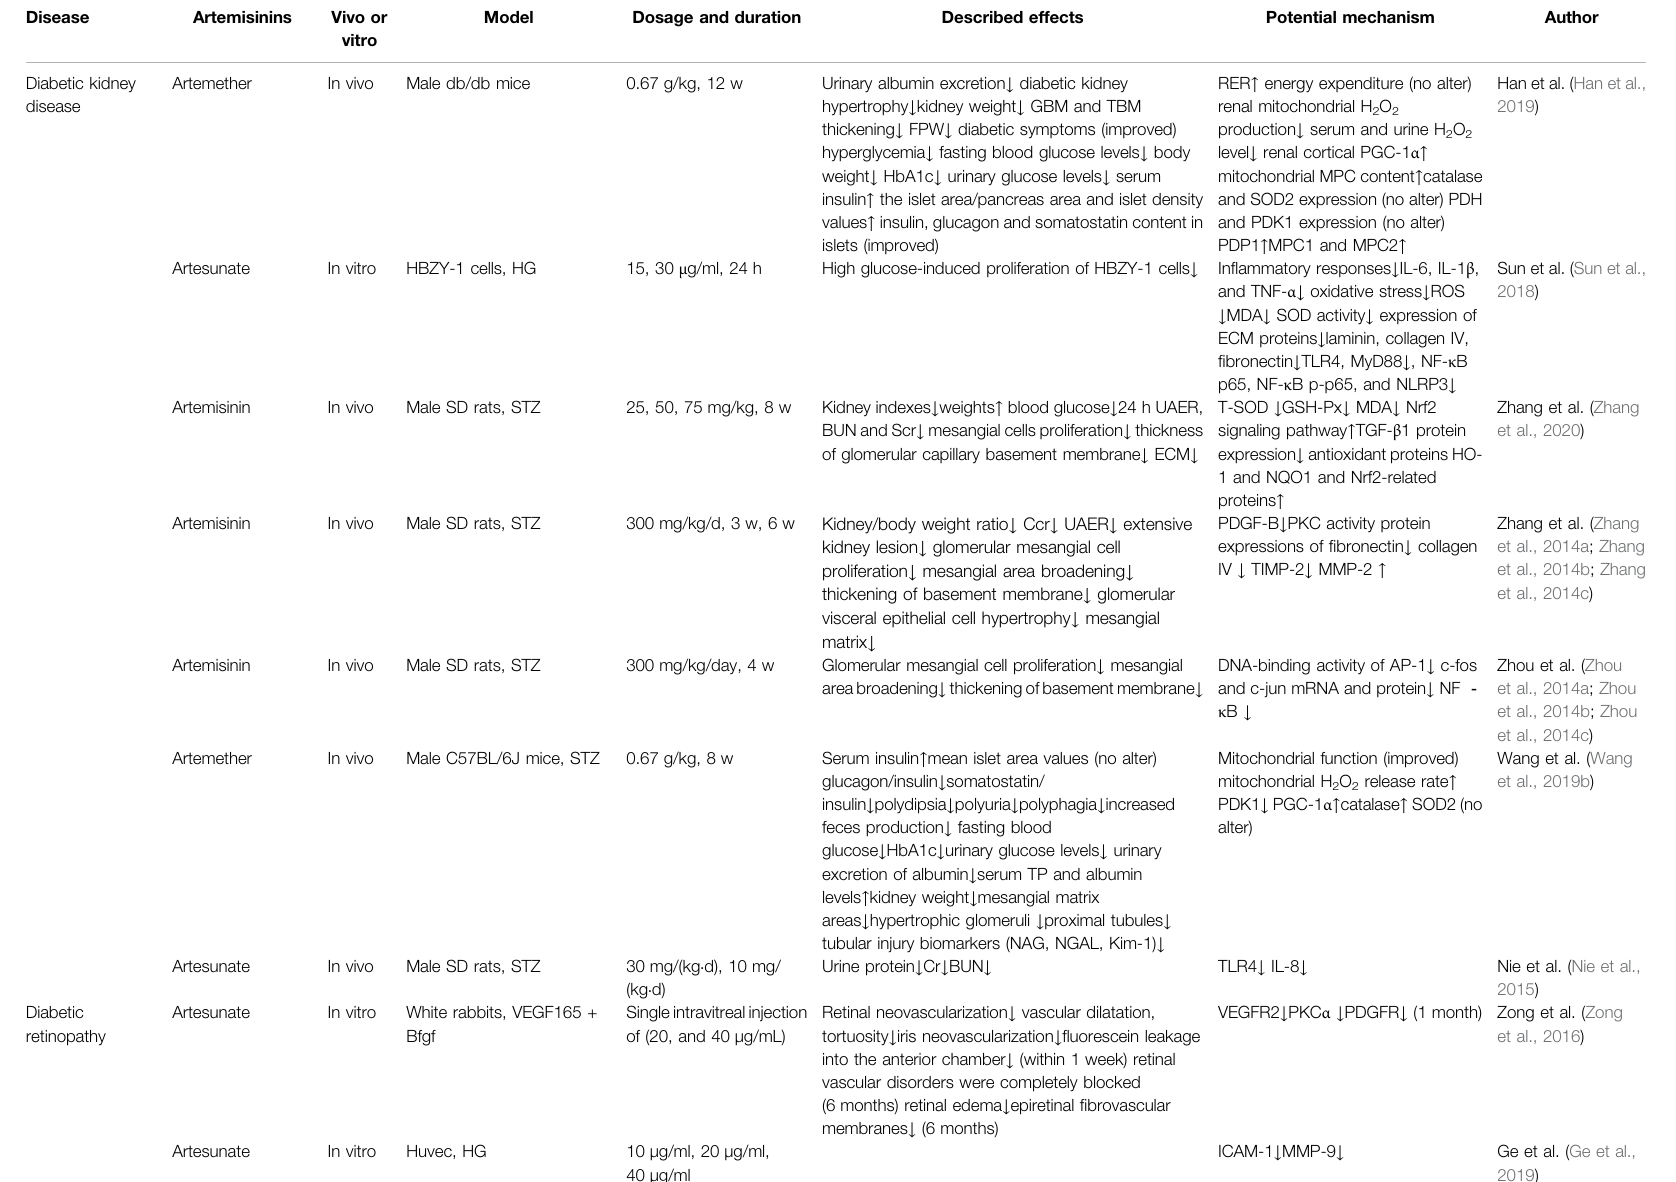
TABLE 2 | Effects of Artemisinins on T2DM Associated Complications.